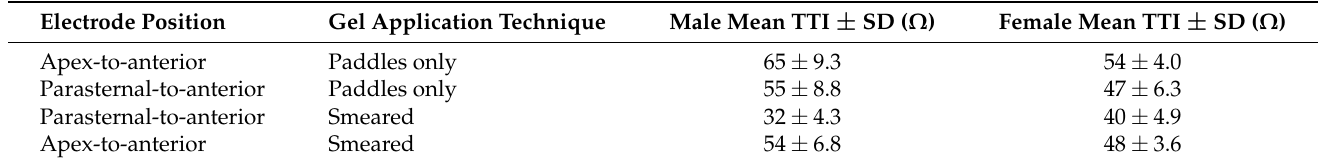
Table 5. Mean ± SD ( Ω ) of TTI at rest under different conditions determined by electrode position and gel application techniques in men ( n = 5) and women ( n = 5)